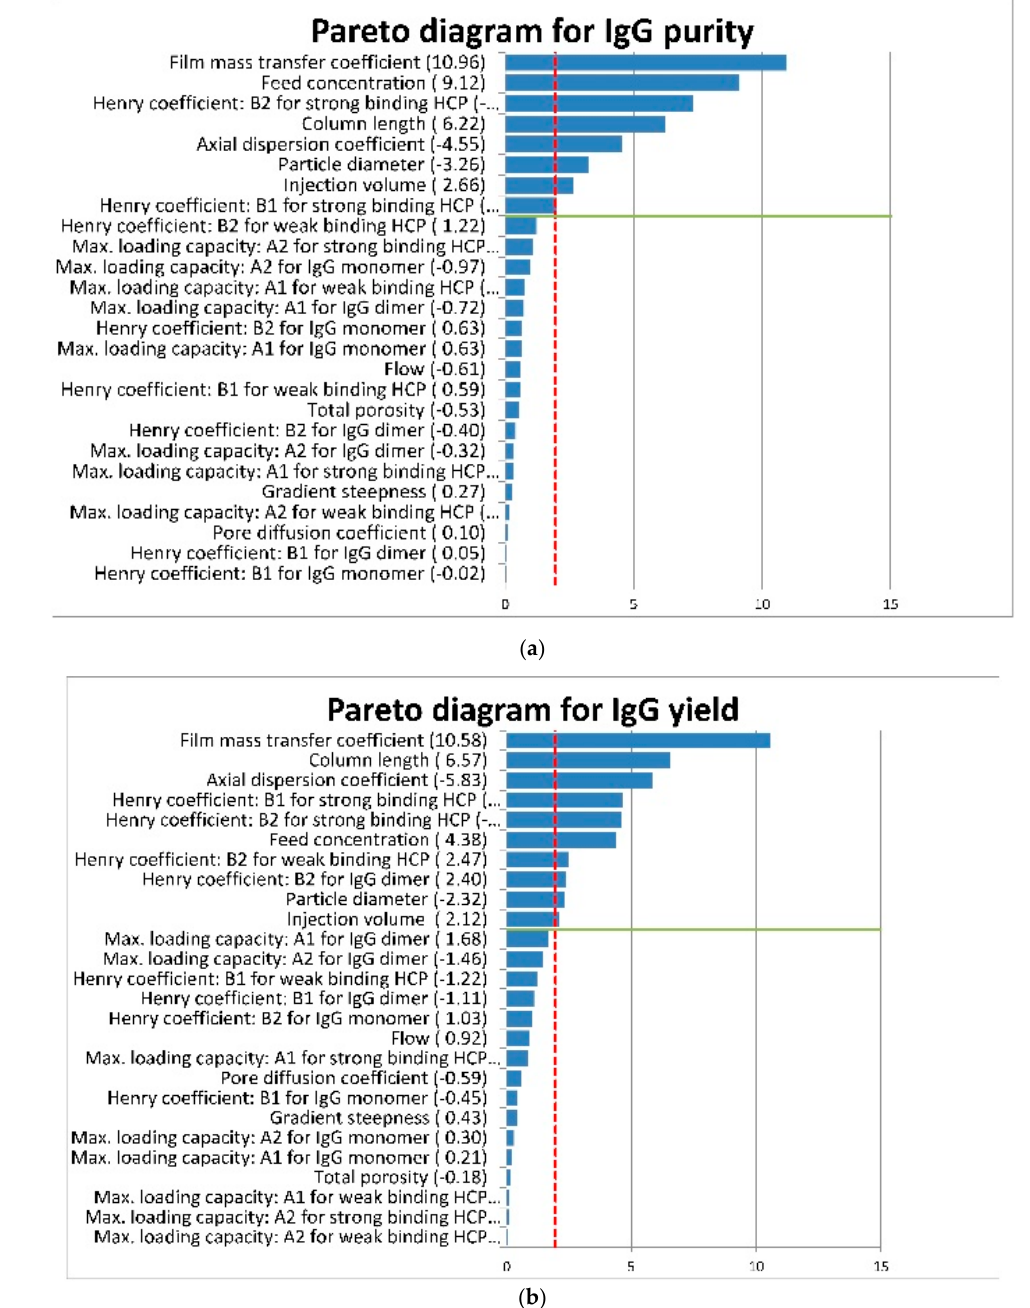
Figure 4. Pareto charts of standardized effects for ( a ) IgG purity and ( b ) IgG yield. Blue bars represent the absolute value of t-ratio, red dotted line shows the boundary for significance, and green line separates between significant (above) and insignificant (below) parameters. Figure 4 indicates the significance of each parameter for IgG purity (left) or IgG yield (right).